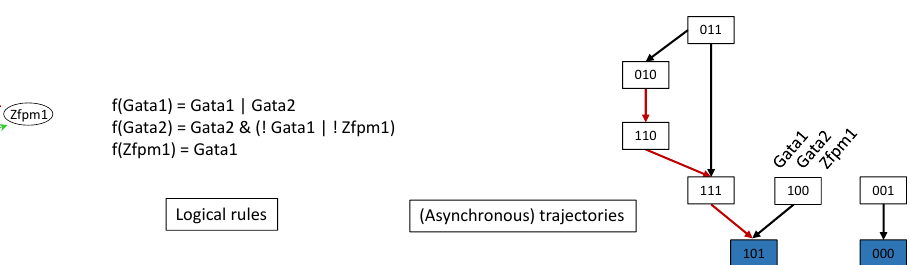
Figure 5 : Example of Boolean network modeling for the three transcription factors Gata1, Gata2 and Zfpm1 in HSC erythroid-priming context. The influence graph represents the gene regulatory network whose dynamics is encoded with logical rules. Transitions between Boolean states (representative of cells at different times of differentiation) can be analyzed by asynchronously updating the components according to logical rules. An influence graph represents the regulations (activations or inhibitions) between selected biological components. Each component of the model is associated with a discrete variable standing for its activity level and logical parameters (using AND, OR and NOT operators) expressing the combined impact of its regulators. The global state of the system is represented by a discrete vector containing the activity values for all components.